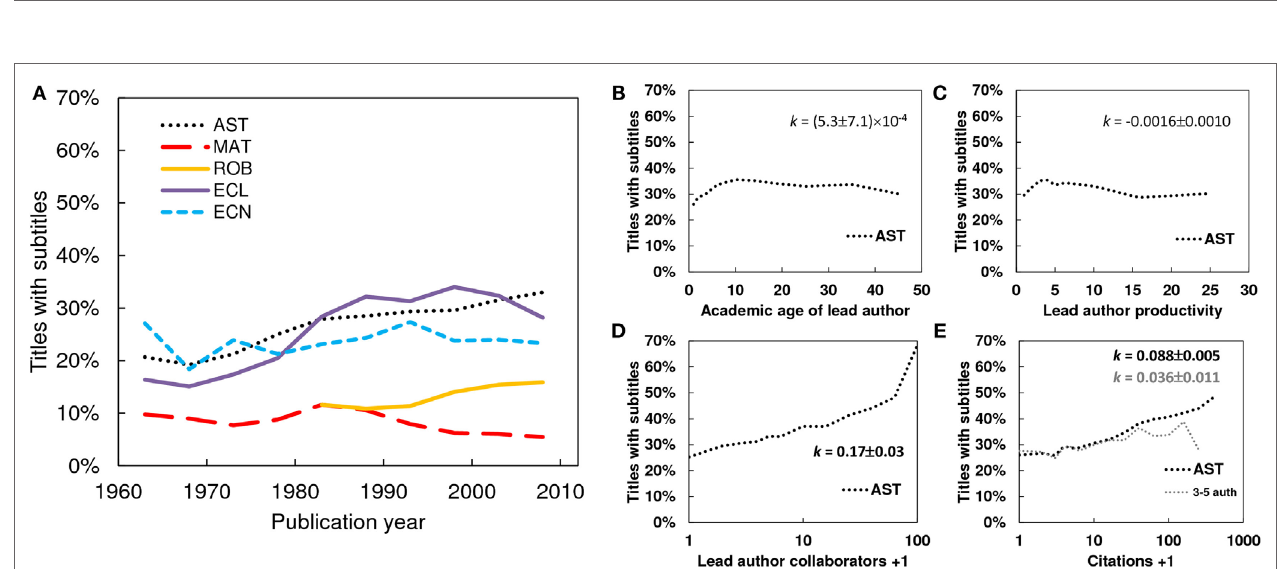
FigUre 2 | Trends involving the presence of subtitles in titles . (a) Percentage of titles with subtitles for five disciplines [astronomy (AST), mathematics (MAT), robotics (ROB), ecology (ECL), and economics (ECN)] from 1961 to 2010. Percentage of titles with subtitles for authors of different academic age (b) , productivity (c) , collaboration level (D) , and papers of different impact level (e) .